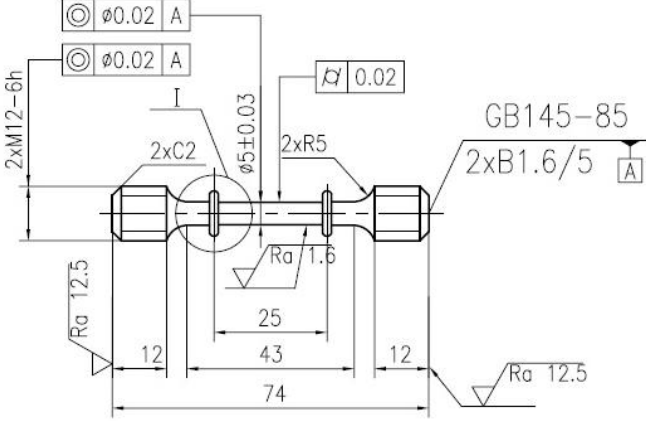
Figure 1. Processing diagram of creep